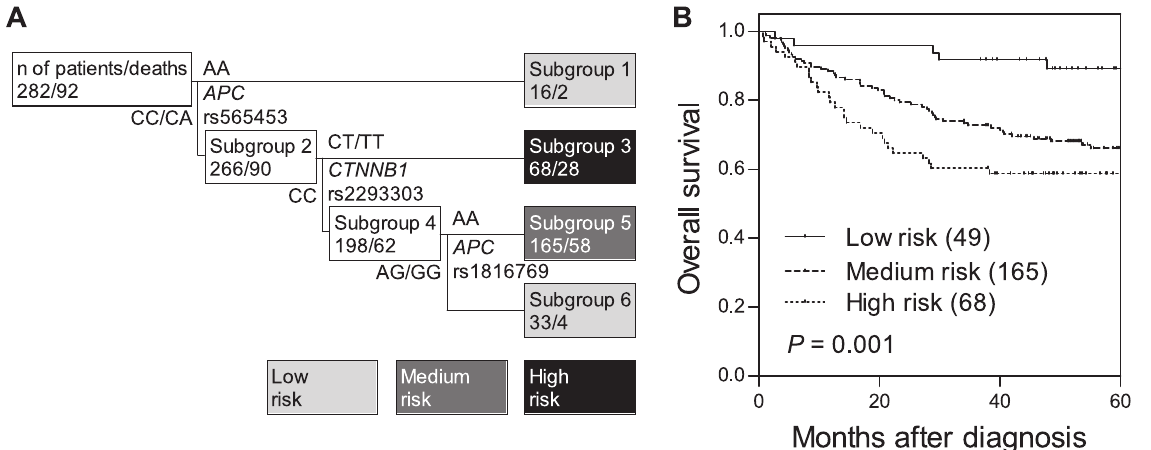
Figure 1. Potential higher order SNP-SNP interactions among Wnt pathway gene polymorphisms. (A) Survival tree analysis identifies the interactions among the three polymorphisms. (B) Kaplan-Meier curves of overall survival based on the survival tree analysis. Numbers in parentheses indicate the number of patients.